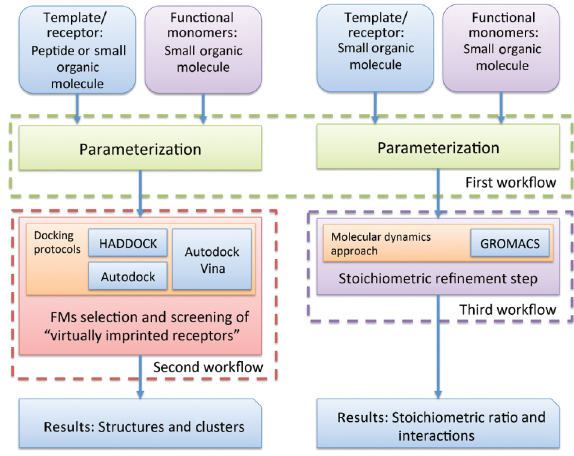
Figure 1: The MIRATE